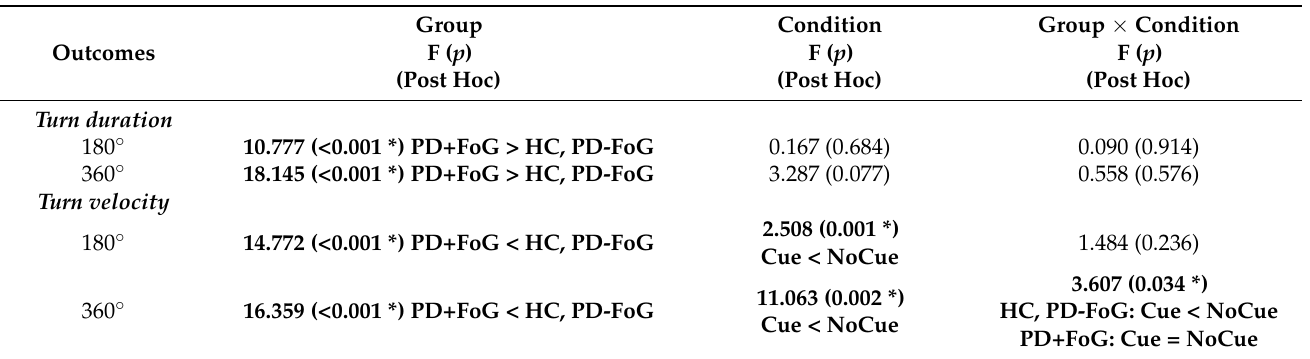
Table 2. Results from the liner mixed effects models (condition: Cue, No Cue; group: controls, PD-FoG and, PD+FoG) for turn outcomes.